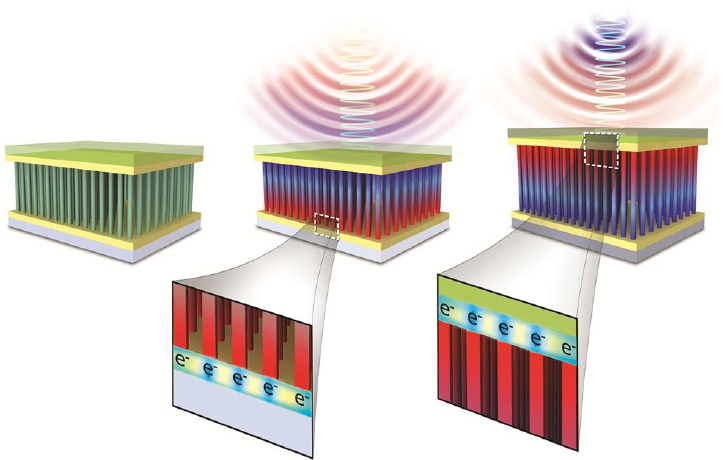
Figure 7. Operation principle of a piezoelectric energy harvester fabricated with ZnO nanowires. Reprinted with permission from [26]. Copyright 2013, Royal Society of